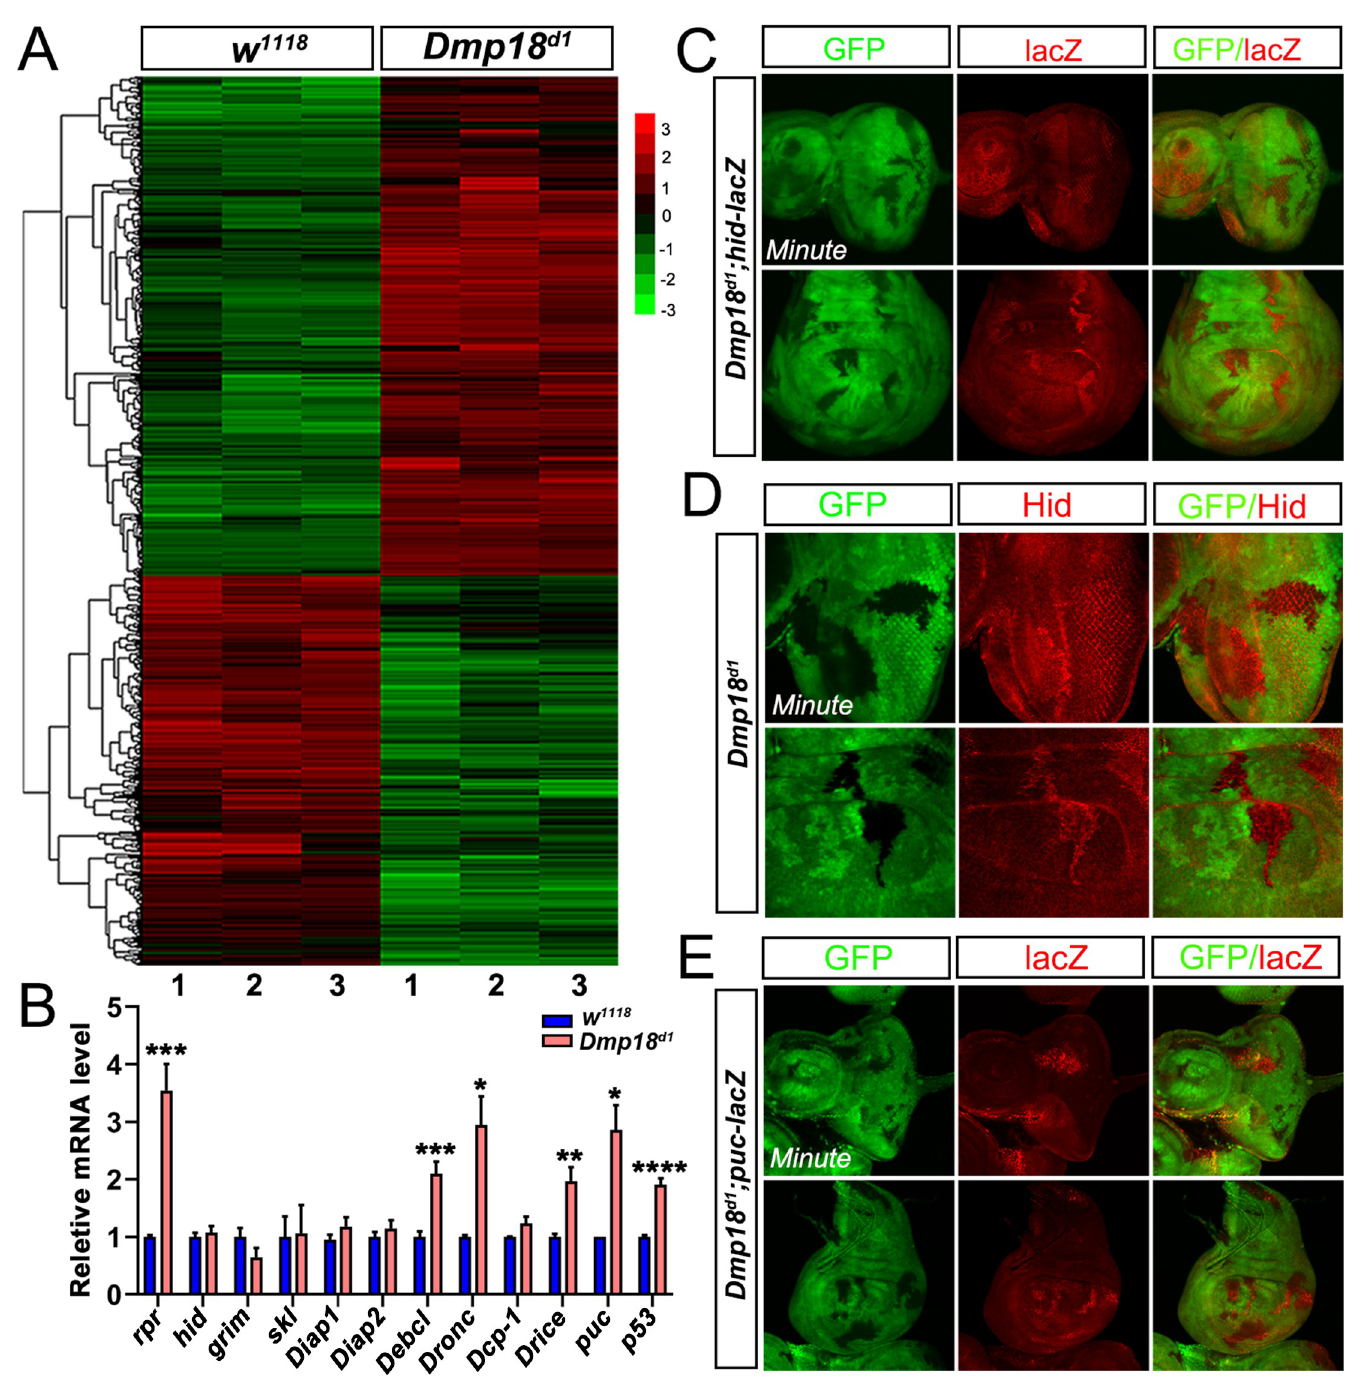
Fig 4. Dmp18 controls the transcription of apoptotic genes. (A) Clustered heatmap of log2-transformed FPKMs (Fragments Per Kilo bases per Million mapped fragments) showed the differentially expressed genes in homozygous Dmp18 d1 . (B) RT-qPCR analysis showed the expression changes of apoptotic-related genes in homozygous Dmp18 d1 . � p < 0.05, �� p < 0.01, ��� p < 0.001 and ���� p < 0.0001. (C) The hid-lacZ was increased in the eye and wing discs in the Dmp18 mutant clones. (D) The Hid protein was increased in the eye and wing discs in the Dmp18 mutant clones. (E) The puc-lacZ was increased in the eye and wing discs in the Dmp18 mutant clones. The GFP-free region marked the Dmp18 mutant clones. Genotypes: C: yw , hs-FLP/+; FRT 40A -M(2L)-Ubi-GFP/FRT 40A -Dmp18 d1 ; hid-lacZ/+ ; D: yw , hs-FLP/+; FRT 40A -M(2L)-Ubi-GFP/FRT 40A -Dmp18 d1 ; E: yw , hs-FLP/+; FRT 40A -M(2L)-Ubi-GFP/FRT 40A -Dmp18 d1 ; puc-lacZ/+ .